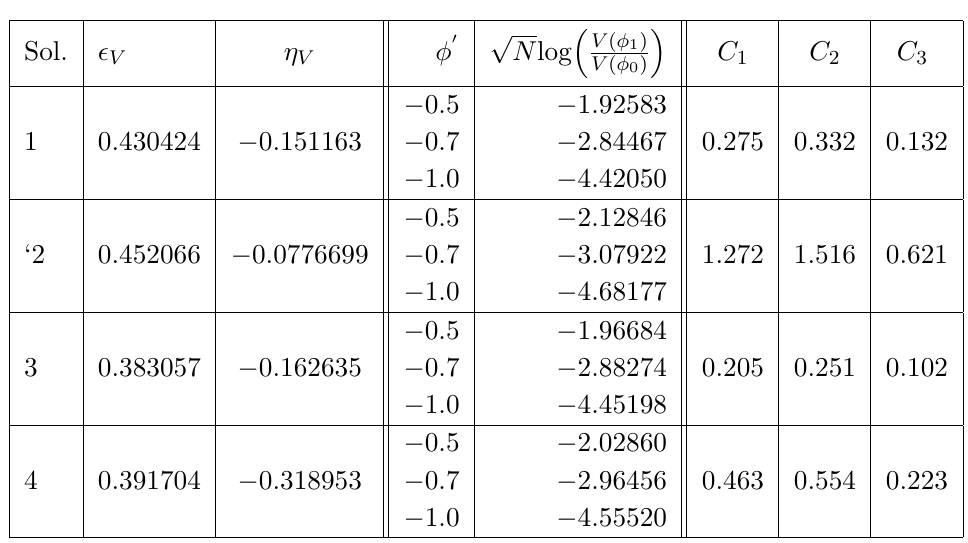
p N ln V ( (cid:30) 1 ) for V 0 (explained in text) corresponding to the cases V ( (cid:30) 0 )